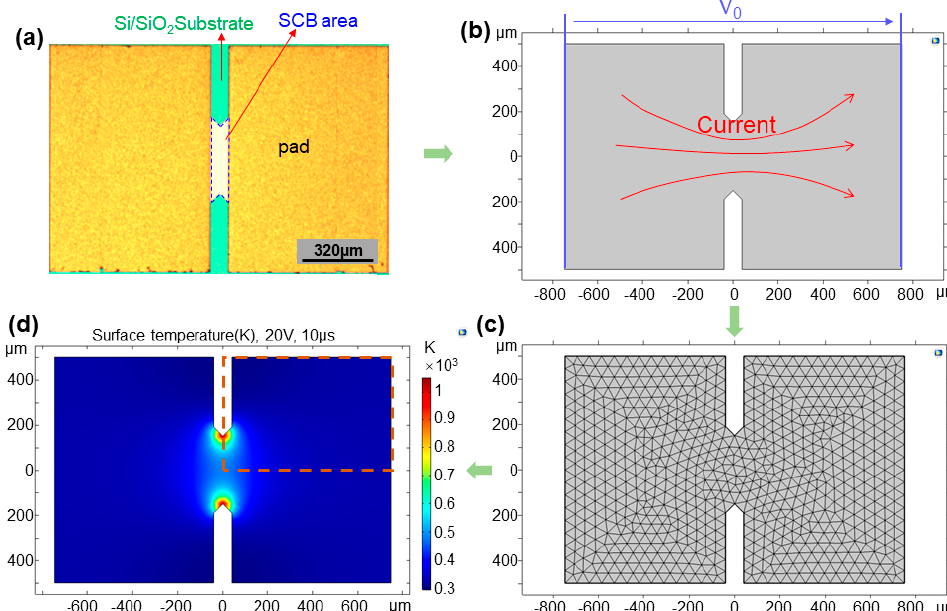
Figure 1. ( a ) Photograph of the SCB initiator, the SCB area is 380 µm × 80 µm with Au/Ti pad on both sides, ( b ) 2D physical simulation of SCBs, a voltage is applied on SCB, ( c ) the finite element mesh division, ( d ) typical surface temperature simulation result of SCBs.